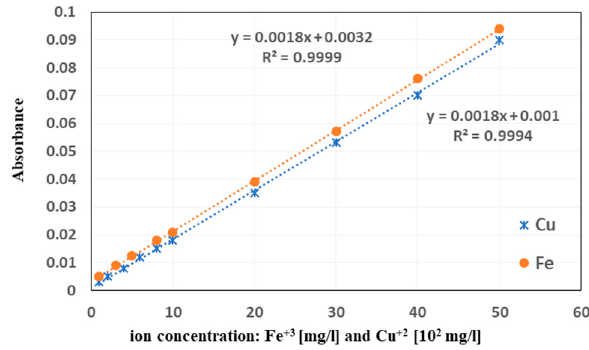
3 + and Cu 2 + ions